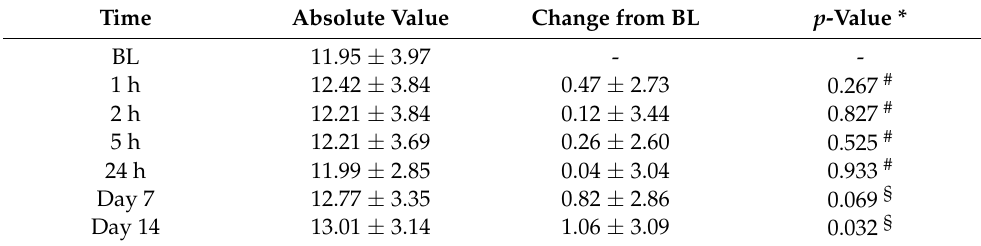
Table 3. Absolute transepidermal water loss (TEWL) measurement values (face, area F1) and changes from the baseline after a single application of the face wash gel (first 24 h) followed by twice-daily applications for 13 days.